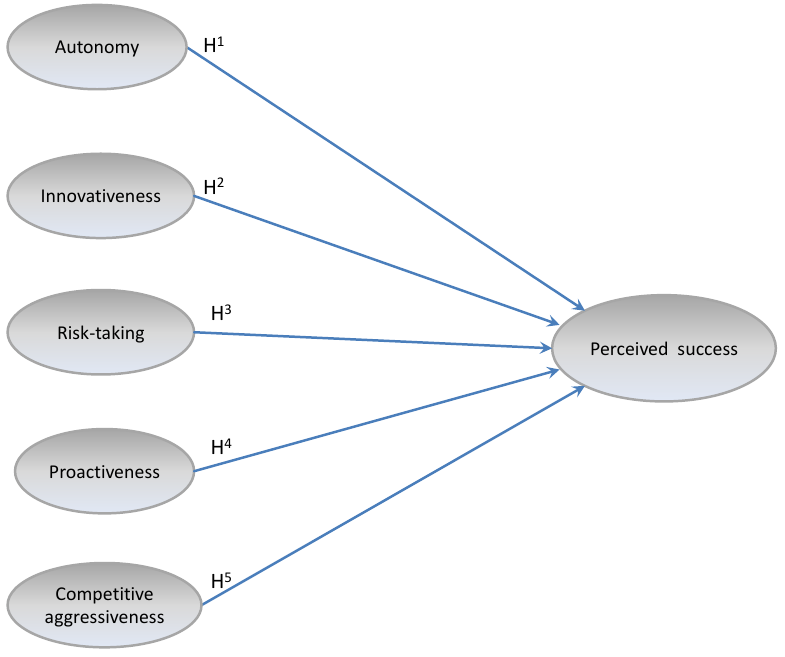
Figure 1: The hypothesised